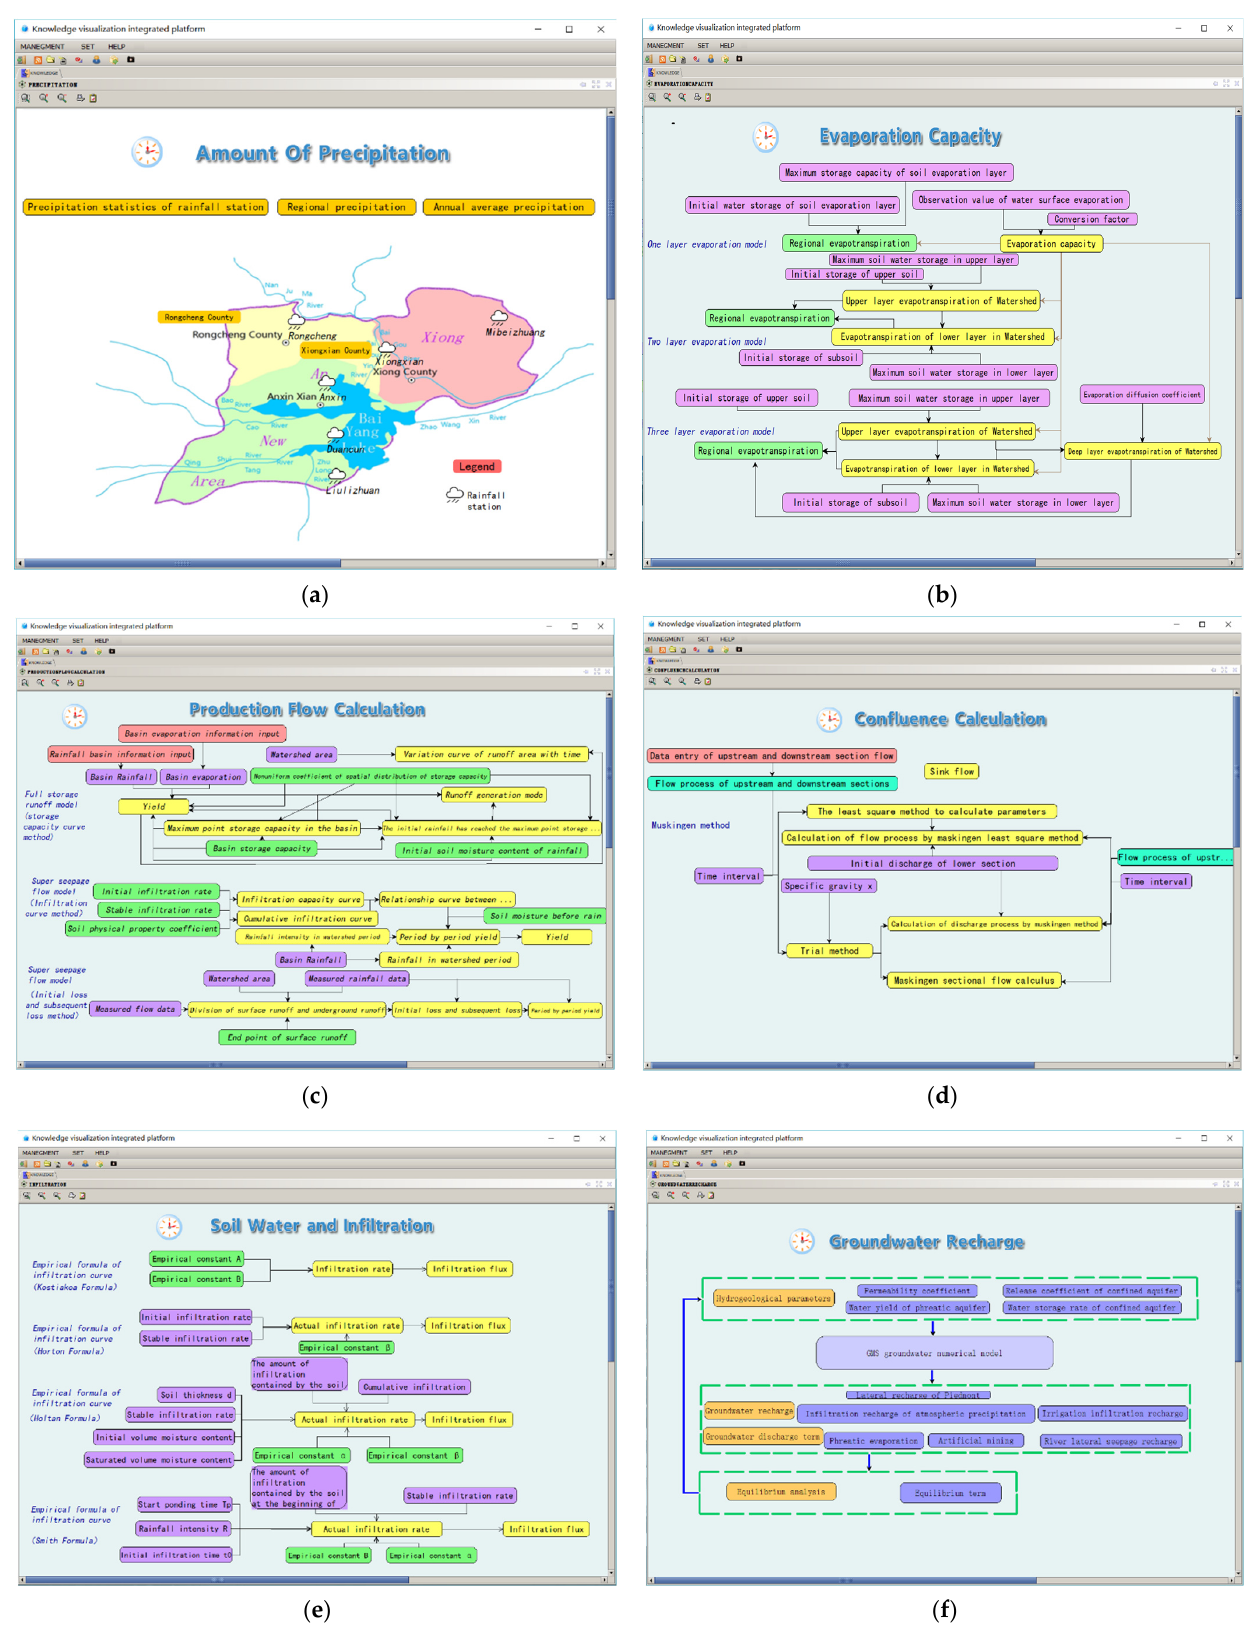
Figure 7. Visual description of the natural water cycle. ( a ) Amount of precipitation interface. ( b ) Evaporation capacity interface. ( c ) Production flow calculation interface. ( d ) Confluence calculation interface. ( e ) Soil water and infiltration interface. ( f ) Groundwater recharge interface.